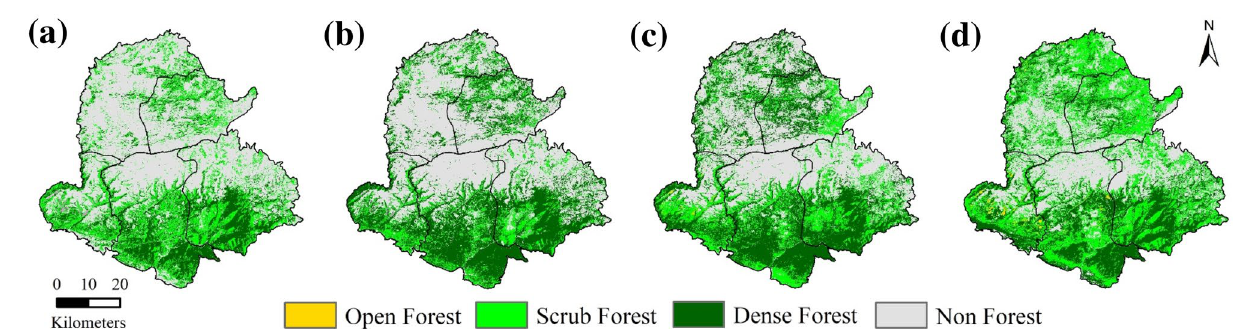
Fig. 3 Classified imageries for the years ( a ) 1995, ( b ) 2001, ( c ) 2007, and ( d ) 2015 using a supervised classification